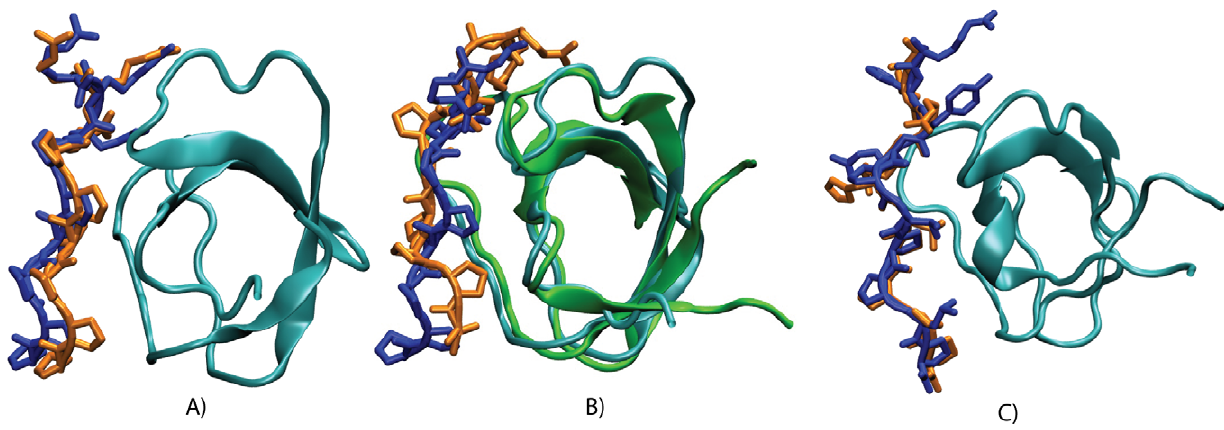
Figure 2. Validation of binding of RP motif to C-SH3. Comparison of the binding sites predicted (in orange) for P1 and the experimental binding site (in blue) for P1 to the (A) NMR structure of the N-SH3 domain (in cyan) (PDB ID 1AZE), and (B) a frame from the molecular dynamics simulation of C-SH3 domain (green). (C) The predicted binding site (orange) for RP peptide to C-SH3 is compared to the NMR structure of the domain bound with a class I peptide (in blue) (PDB ID 1IO6).